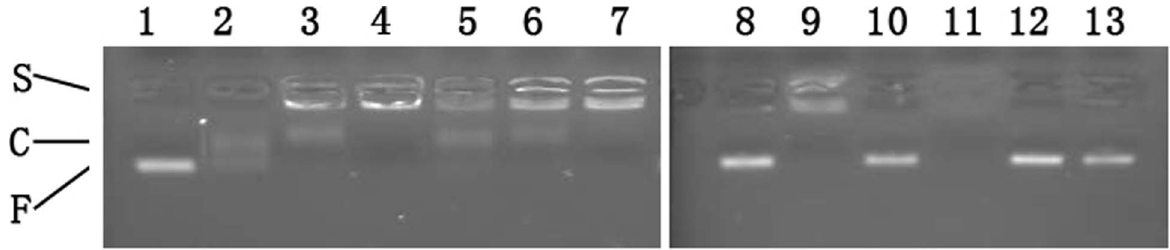
Figure 5. EMSA analysis of the binding of aptamer b B-1 to b -BuTx and five snake venoms. One hundred nM of b B-1 was incubated at RT for 40 min with 240 nM (2), 480 nM (3), 960 nM (4) of b -BuTx, 15 m g/mL (5), 30 m g/mL (6), 50 m g/mL (7 and 9) of B. multicinctus venom, and 50 m g/mL of venom of B. fasciatus (10), Naja Naja Atra (11), D. acutus (12), and G. brevicaudus (13). Lane 1 and Lane 8: no protein or venom added. F: free DNA; C: DNA/protein complex; S: DNA stuck in well.